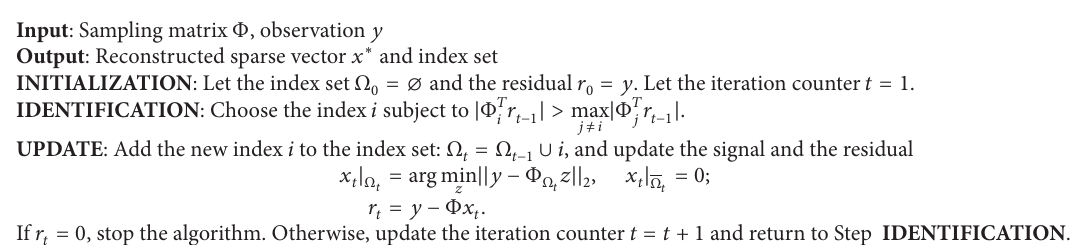
Algorithm 1: Orthogonal matching pursuit—OMP ( Φ,𝑦